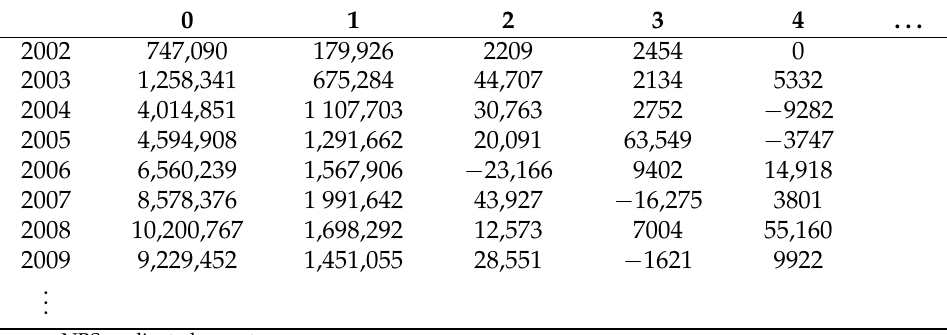
Table 18. Triangle of non-cumulative payments for Motor